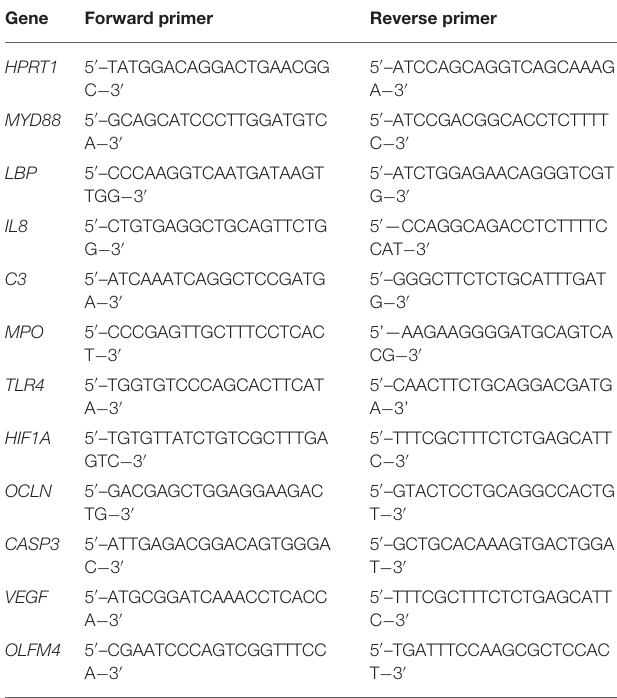
TABLE 2 | List of primer sequences used for quantitative PCR